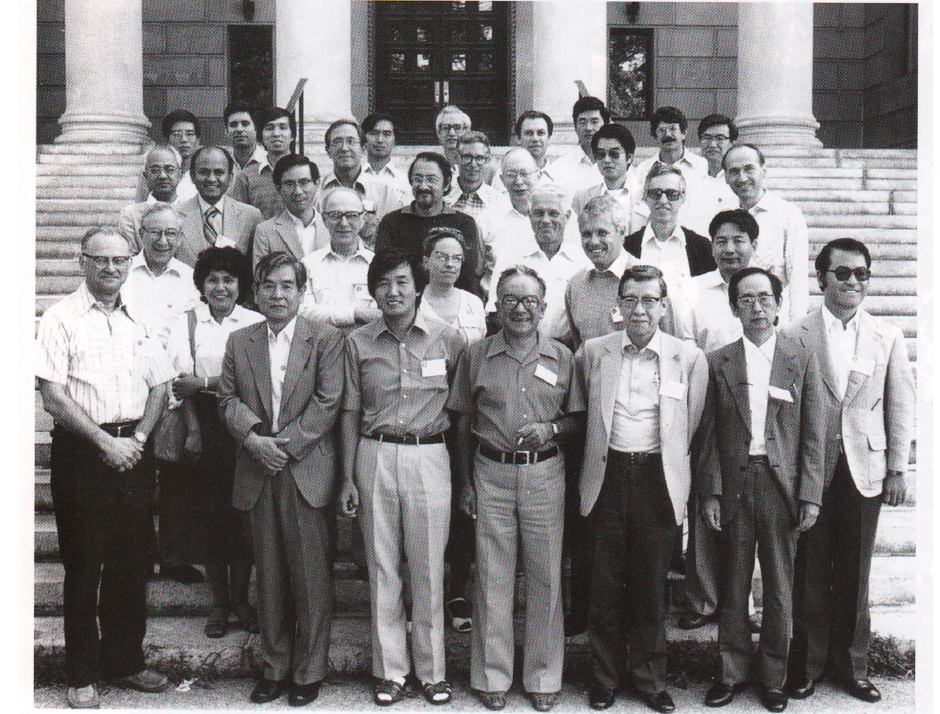
Figure 2. A year before the Padova meeting, O. B. Ptitsyn (first row, fourth from left) and A. Wada (third row, first from left) had met in New York in 1981 during the USA–Japan Seminar on Self-organization Protein Molecules, which was attended by several established Japanese and American protein biophysicists (by courtesy of Prof. A. V. Finkelstein).